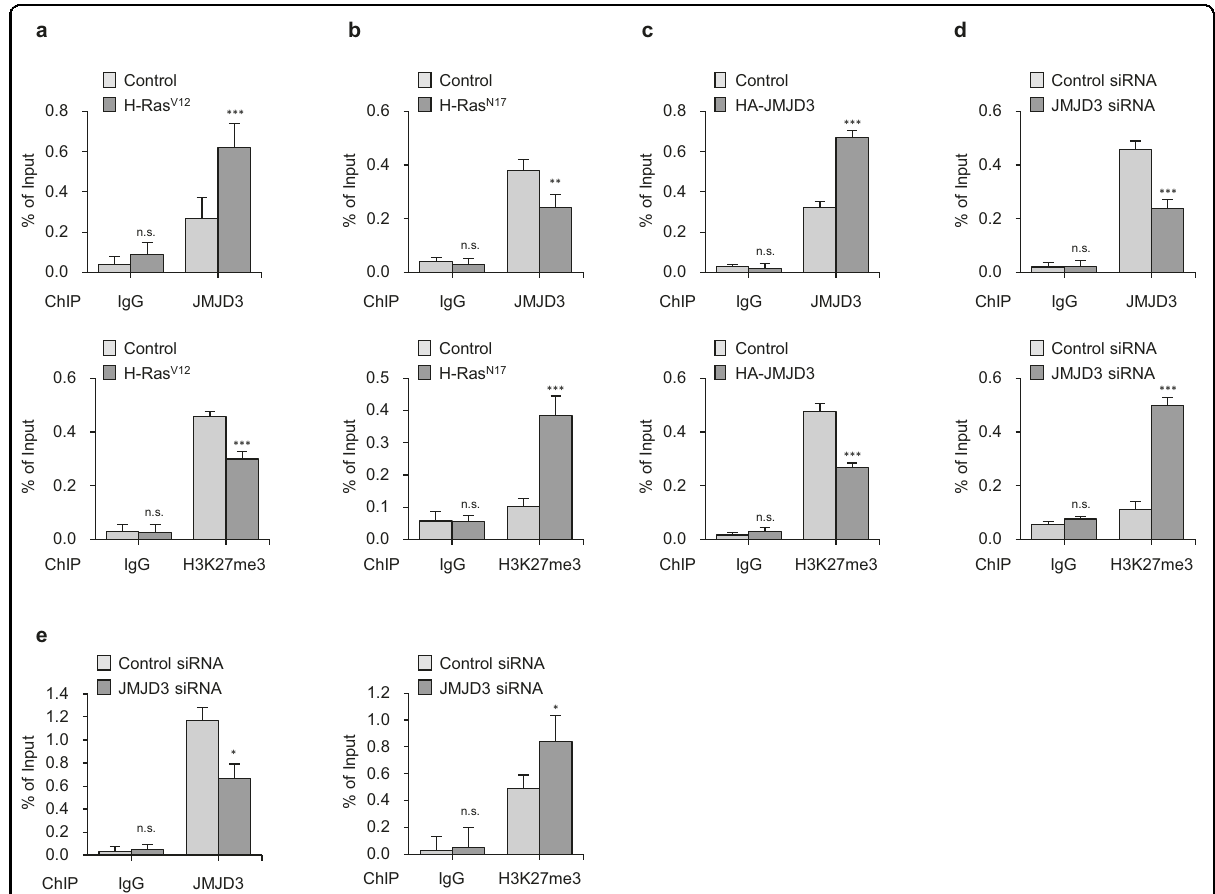
Fig. 5 JMJD3 binds to syntenin promoter and demethylates H3K27me3. a ChIP assay of JMJD3 (upper panel) and H3K27me3 (lower panel) recruitment at syntenin promoter using IgG, JMJD3, or H3K27me3 antibody in H-Ras V12 -expressed BEAS-2B cells. Columns, mean of two independent experiments performed in triplicate; bar , S.D.; *** P <0.001 versus control in each group, n.s.: nonsigni fi cant. b ChIP assay of JMJD3 (upper panel) and H3K27me3 (lower panel) recruitment at syntenin promoter using IgG, JMJD3, or H3K27me3 antibody in H-Ras N17 -expressed BZR cells. Columns, mean of two independent experiments performed in triplicate; bar , S.D.; ** P <0.01, *** P < 0.001 versus control in each group, n.s.: nonsigni fi cant. c ChIP assay of JMJD3 (upper panel) and H3K27me3 (lower panel) recruitment at syntenin promoter using IgG, JMJD3, or H3K27me3 antibody in HA-JMJD3-expressed BEAS-2B cells. Columns, mean of two independent experiments performed in triplicate; bar , S.D.; ***P< 0.001 versus control in each group, n.s.: nonsigni fi cant. d ChIP assay of JMJD3 (upper panel) and H3K27me3 (lower panel) recruitment at syntenin promoter using IgG, JMJD3, or H3K27me3 antibody in BZR cells in response to JMJD3 knockdown. Columns, mean of two independent experiments performed in triplicate; bar , S.D.; *** P <0.001 versus control in each group, n.s.: nonsigni fi cant. e ChIP assay of JMJD3 (upper panel) and H3K27me3 (low e r panel) recruitment at syntenin promoter using IgG, JMJD3, or H3K27me3 antibody in A549 cells in response to JMJD3 knockdown. Columns, mean of two independent experiments performed in triplicate; bar , S.D.; * P < 0.05 versus control in each group, n.s.: nonsigni fi cant.